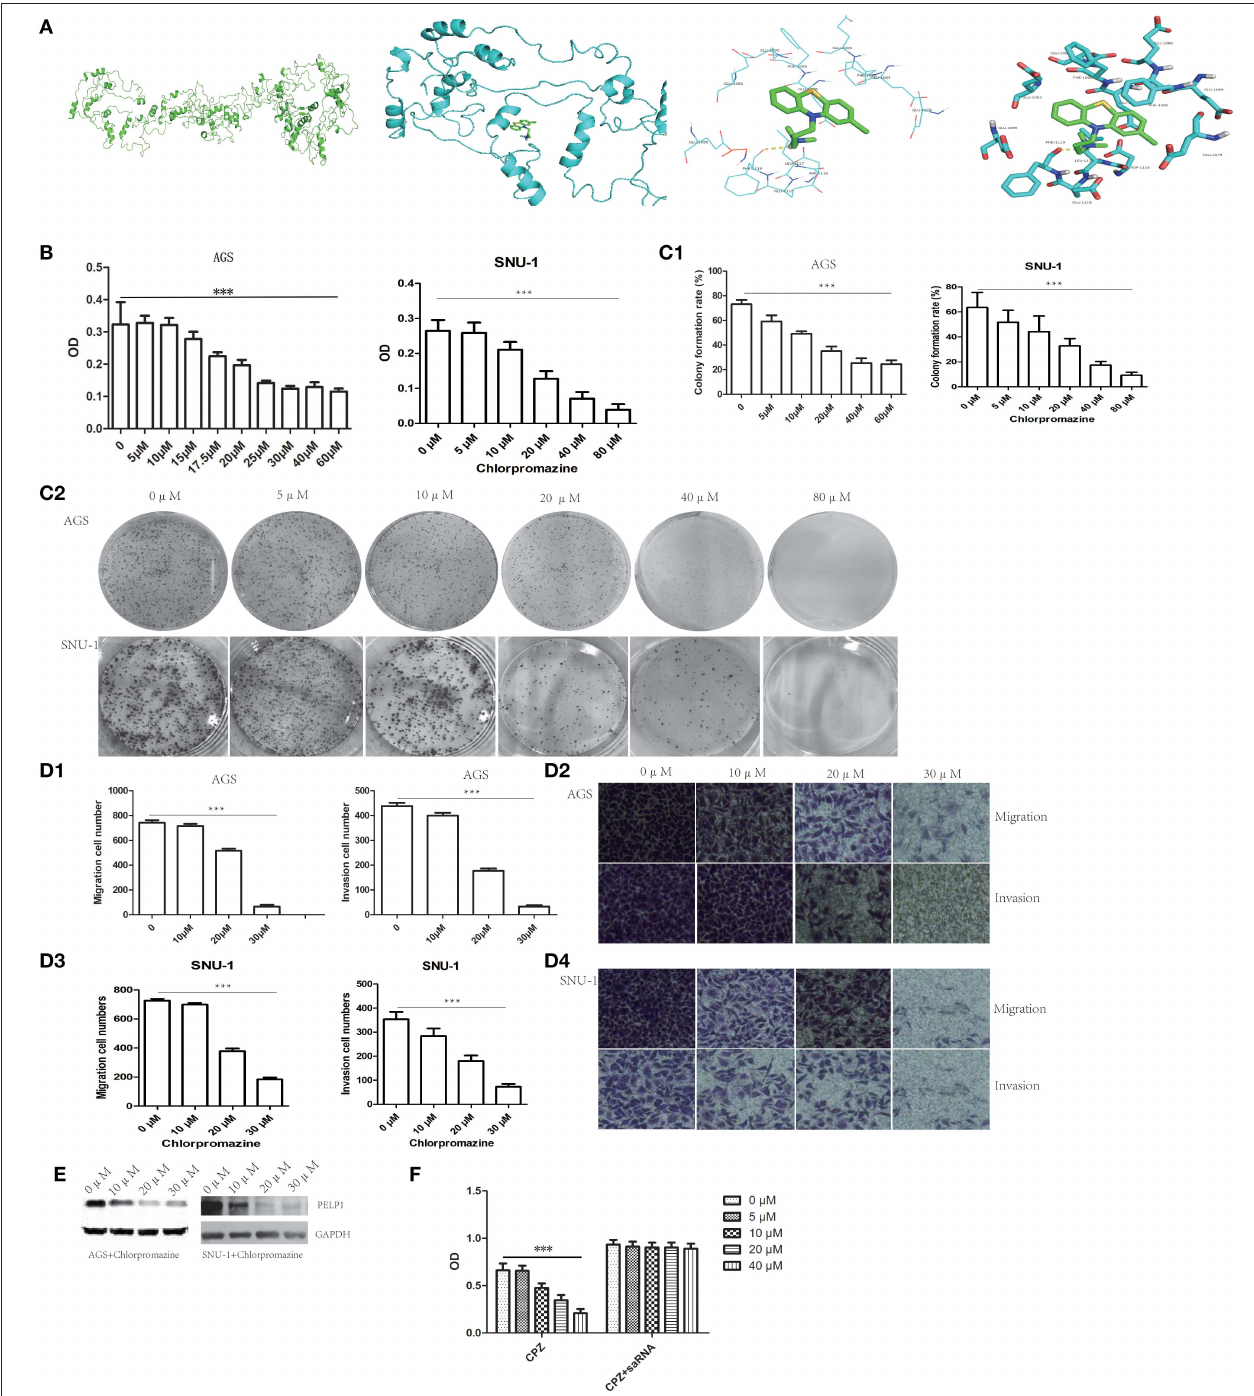
FIGURE 6 | PELP1 can be targeted by chlorpromazine in GC. (A) Chlorpromazine interacts with PELP1 in molecular docking model. (B) The absorbance (OD) at 450nm wave-length was reduced in chlorproazine groups in MTT assays dose-dependently. (C1,C2) The colony formation ability of AGS and SNU-1 were inhibited with the increasing of CPZ. Transwell small chamber assay revealed CPZ suppressed the migration and invasion ability of AGS (D1,D2) and SNU-1 cell (D3,D4) . (E) CPZ inhibited the protein expression of PELP1 in AGS and SNU-1. (F) PELP1 activation compromised the CPZ’s inhibitory effect on GC AGS cell. Experiments were repeated 3 or 4 times. Values are the mean ± SEM (*** p < 0.001).